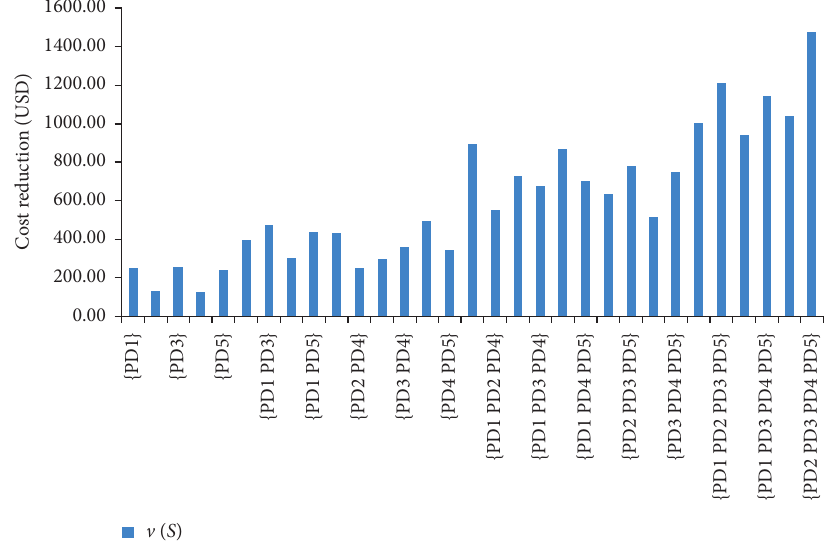
Figure 6: Cost reduction variations of different